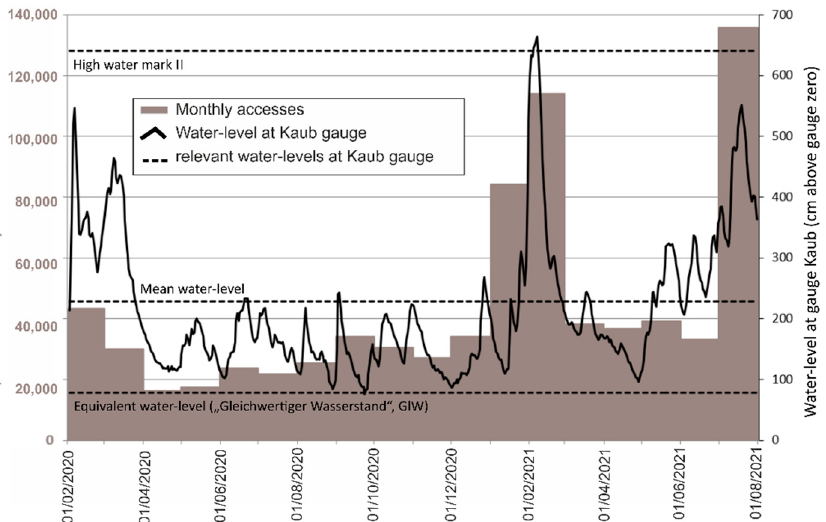
Figure 8. Monthly accesses to the 10-day water-level forecast for the Rhine against the backdrop of water levels recorded at gauge Kaub from February 2020 to August 2021.